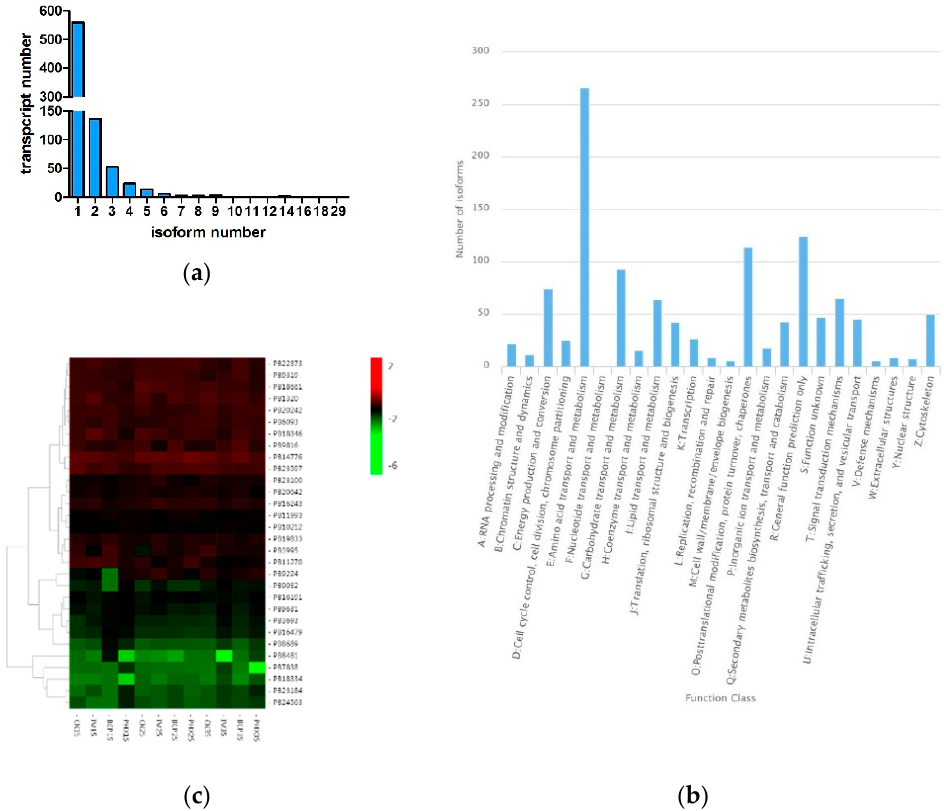
Figure 2. Alternative splicing analysis of the full-length transcriptome. ( a ) Distribution of the transcripts that have one or more alternative isoforms. ( b ) KOG annotation of the transcripts with one or more alternative isoforms. ( c ) Expression heatmap of the transcript with the most isoforms.